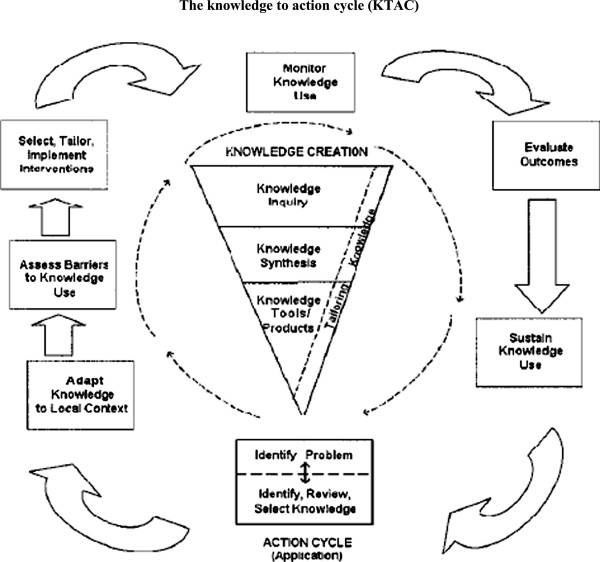
Study flow diagram. This figure provides a flow diagram of data collection from baseline to 18-months follow-up.